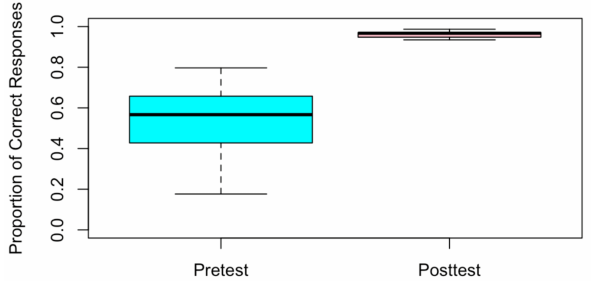
Fig. 3. Proportion of correct responses to test questions before and after the VR session ( p = 0.016).